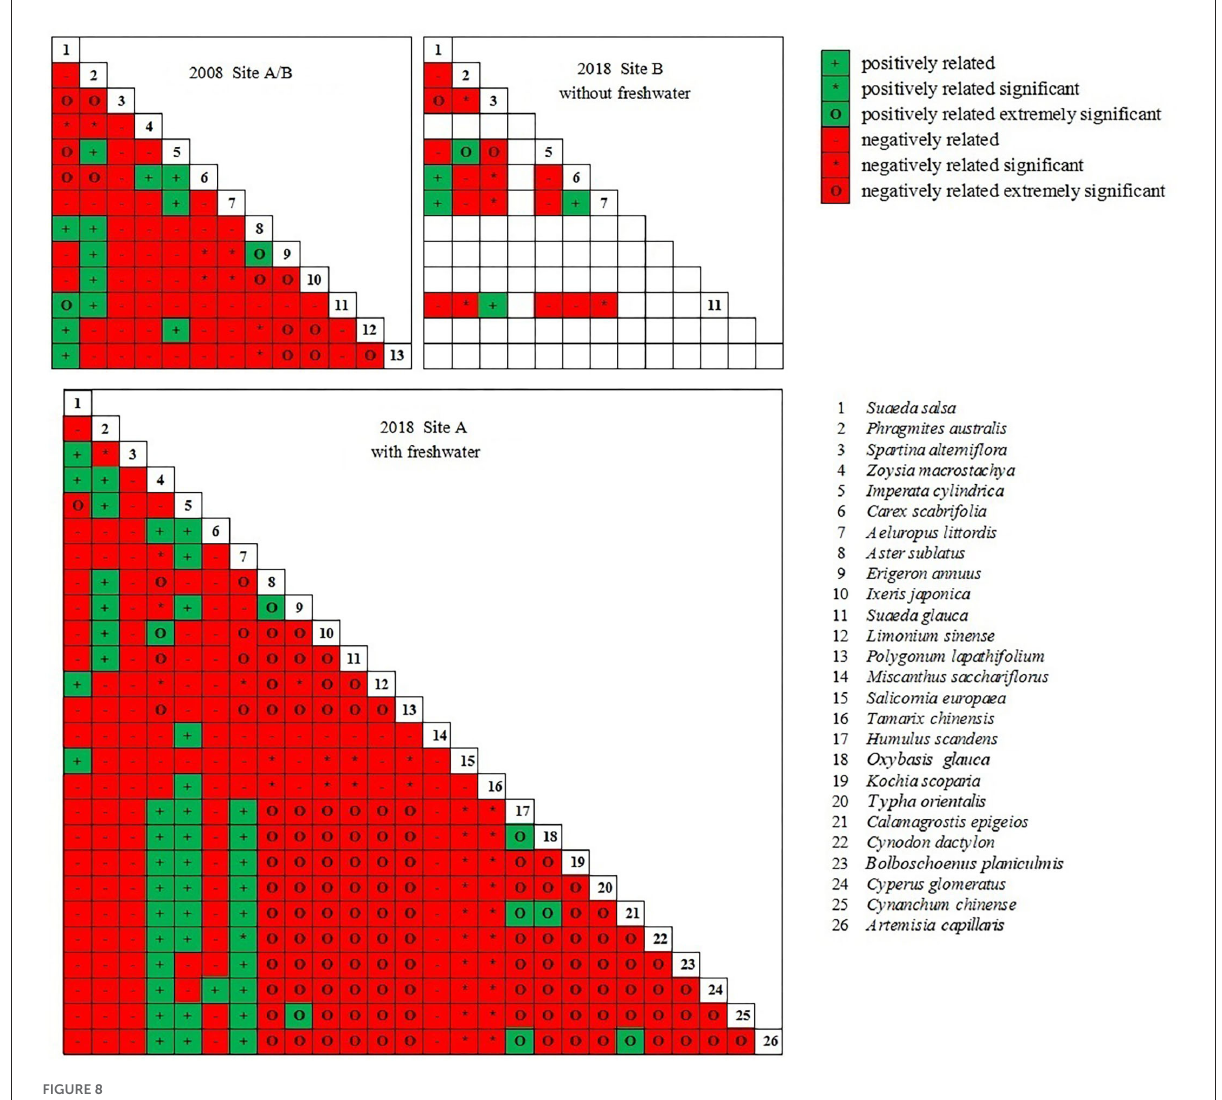
FIGURE8 Semi-matrix for chi-square test of dominant